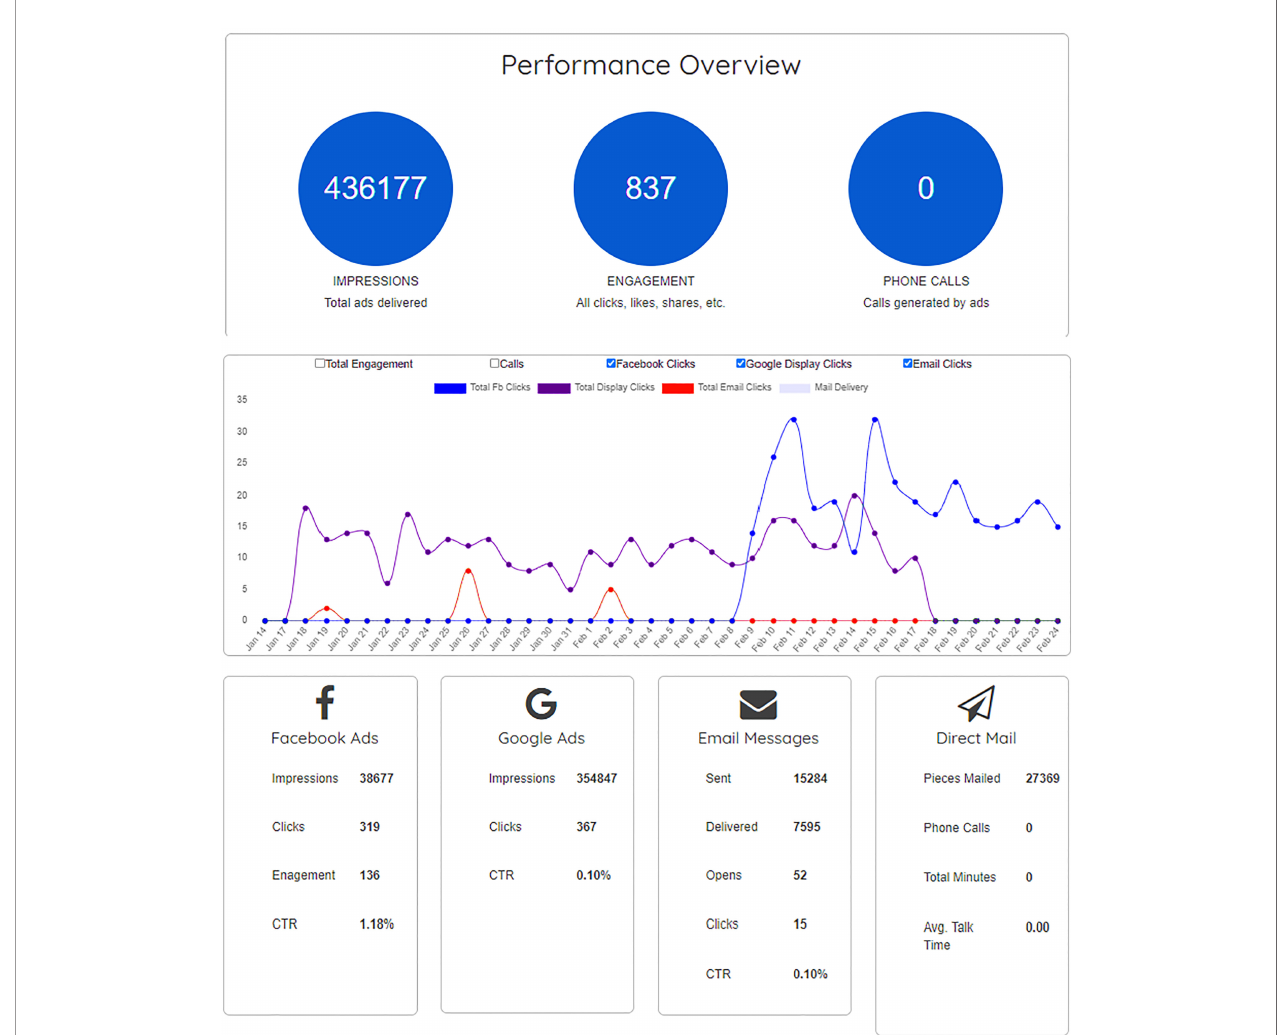
FIGURE 5 | Detailed data on the Facebook Ads, Google Ads, Emails, and Direct Mail from